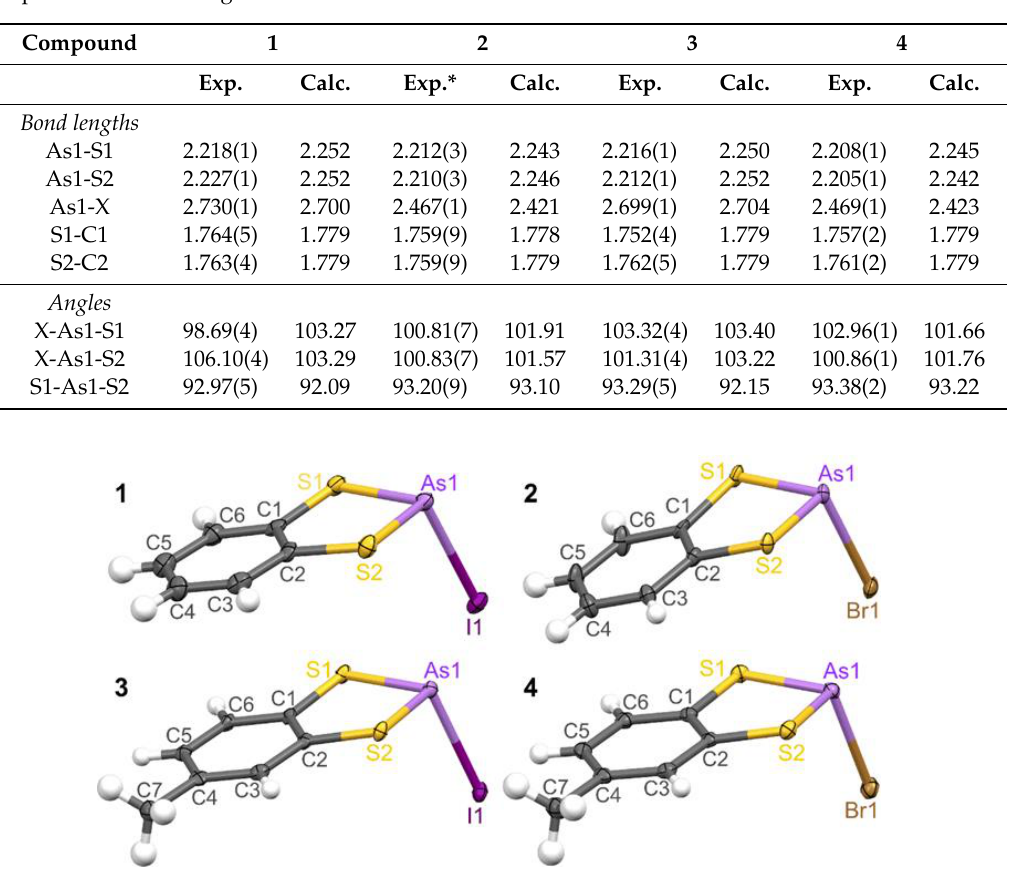
Figure 3. Fragment of the crystal structure of 1 showing some intermolecular interactions between AsI(PhS 2 ) molecules.